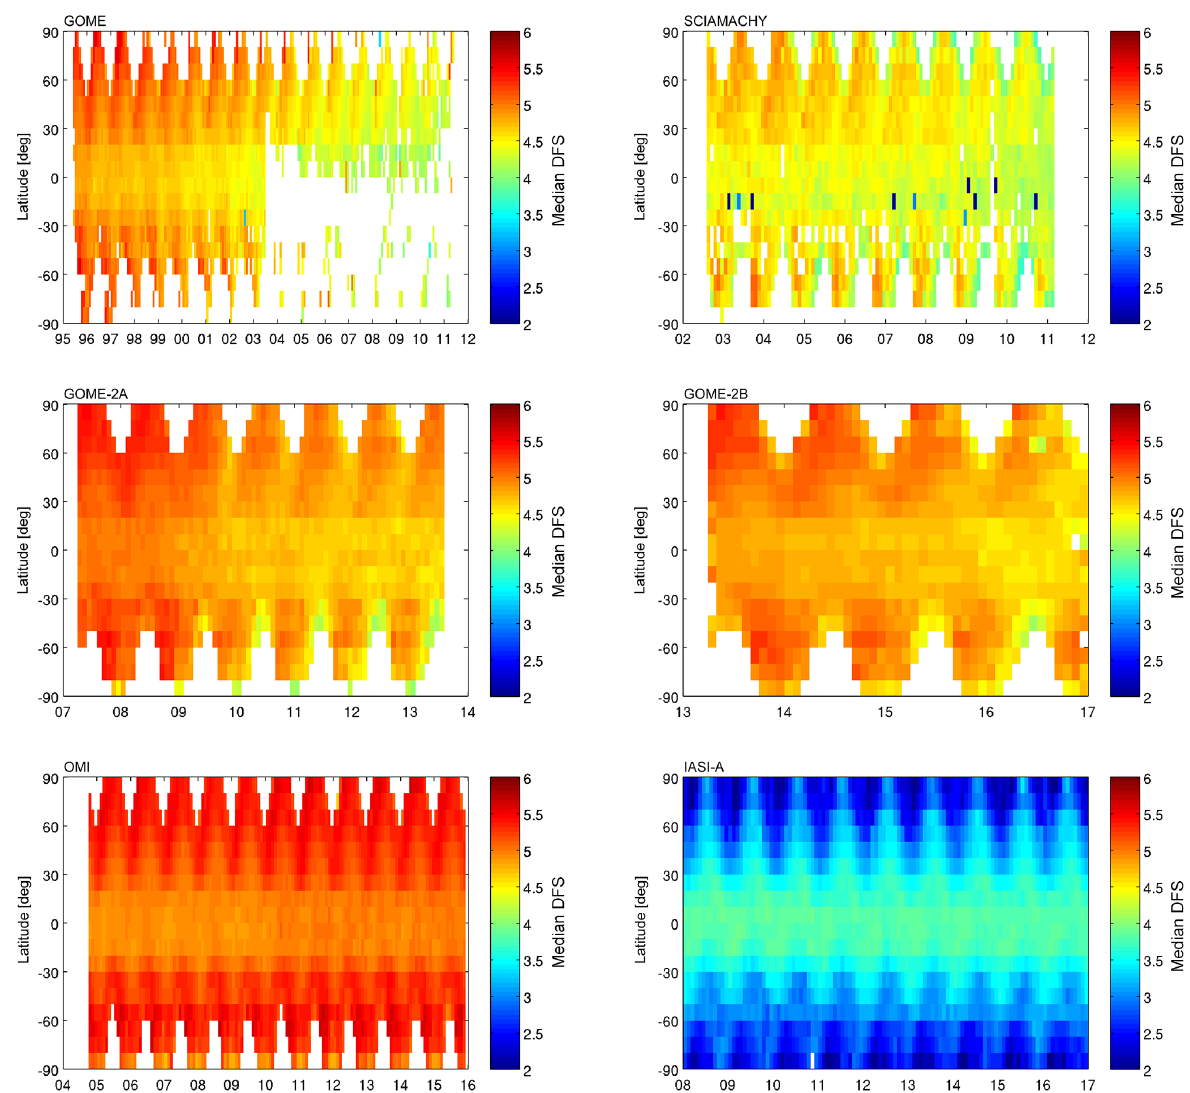
Figure 4. GOME, SCIAMACHY, GOME-2A, GOME-2B, OMI, and IASI-A (left to right and top to bottom panels) latitude–time distribution of degrees of freedom in the signal (DFS). IASI-B is fully similar to